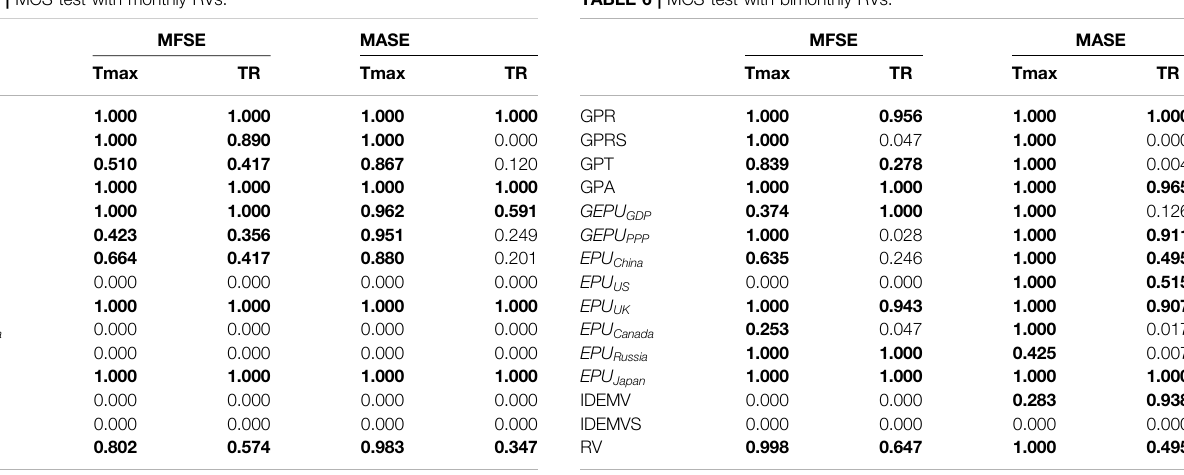
TABLE 5 | MCS test with monthly RVs. TABLE 6 | MCS test with bimonthly